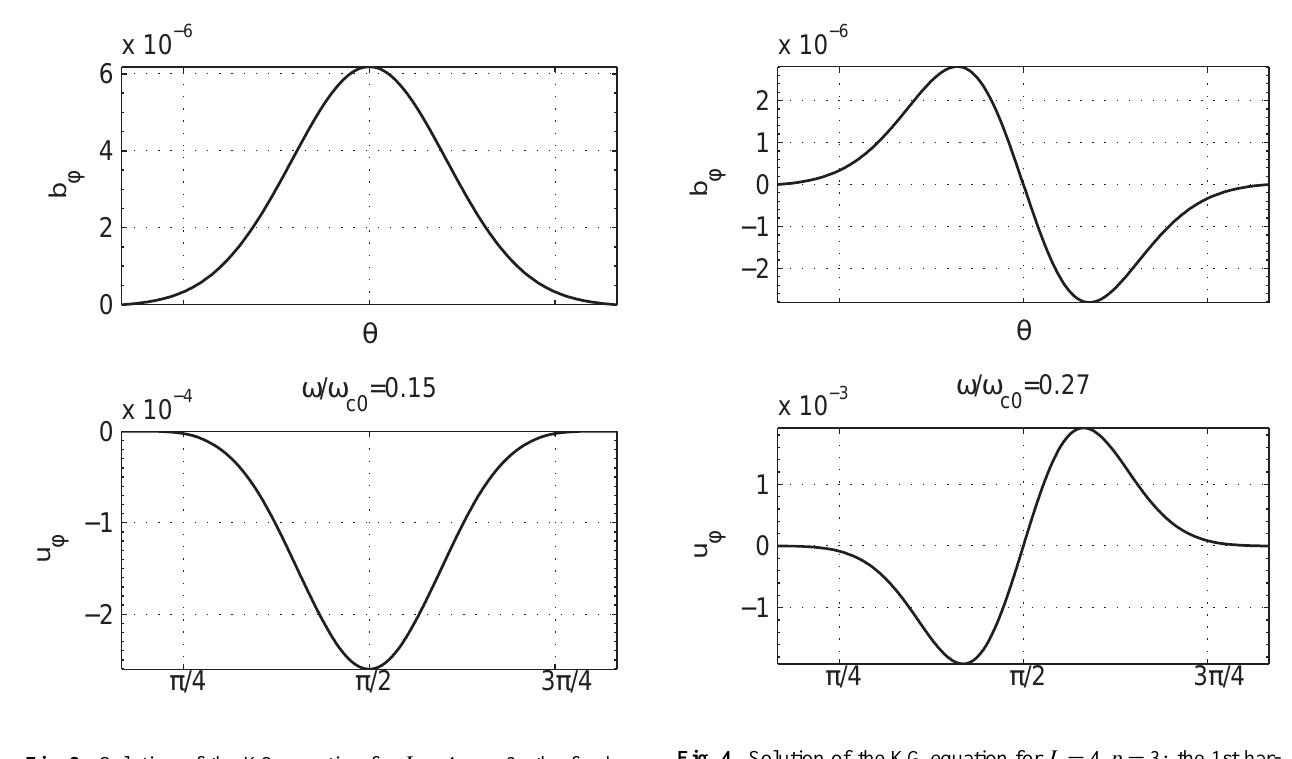
Fig. 4. Solution of the KG equation for L = 4 ,p = 3 : the 1st harmonic.